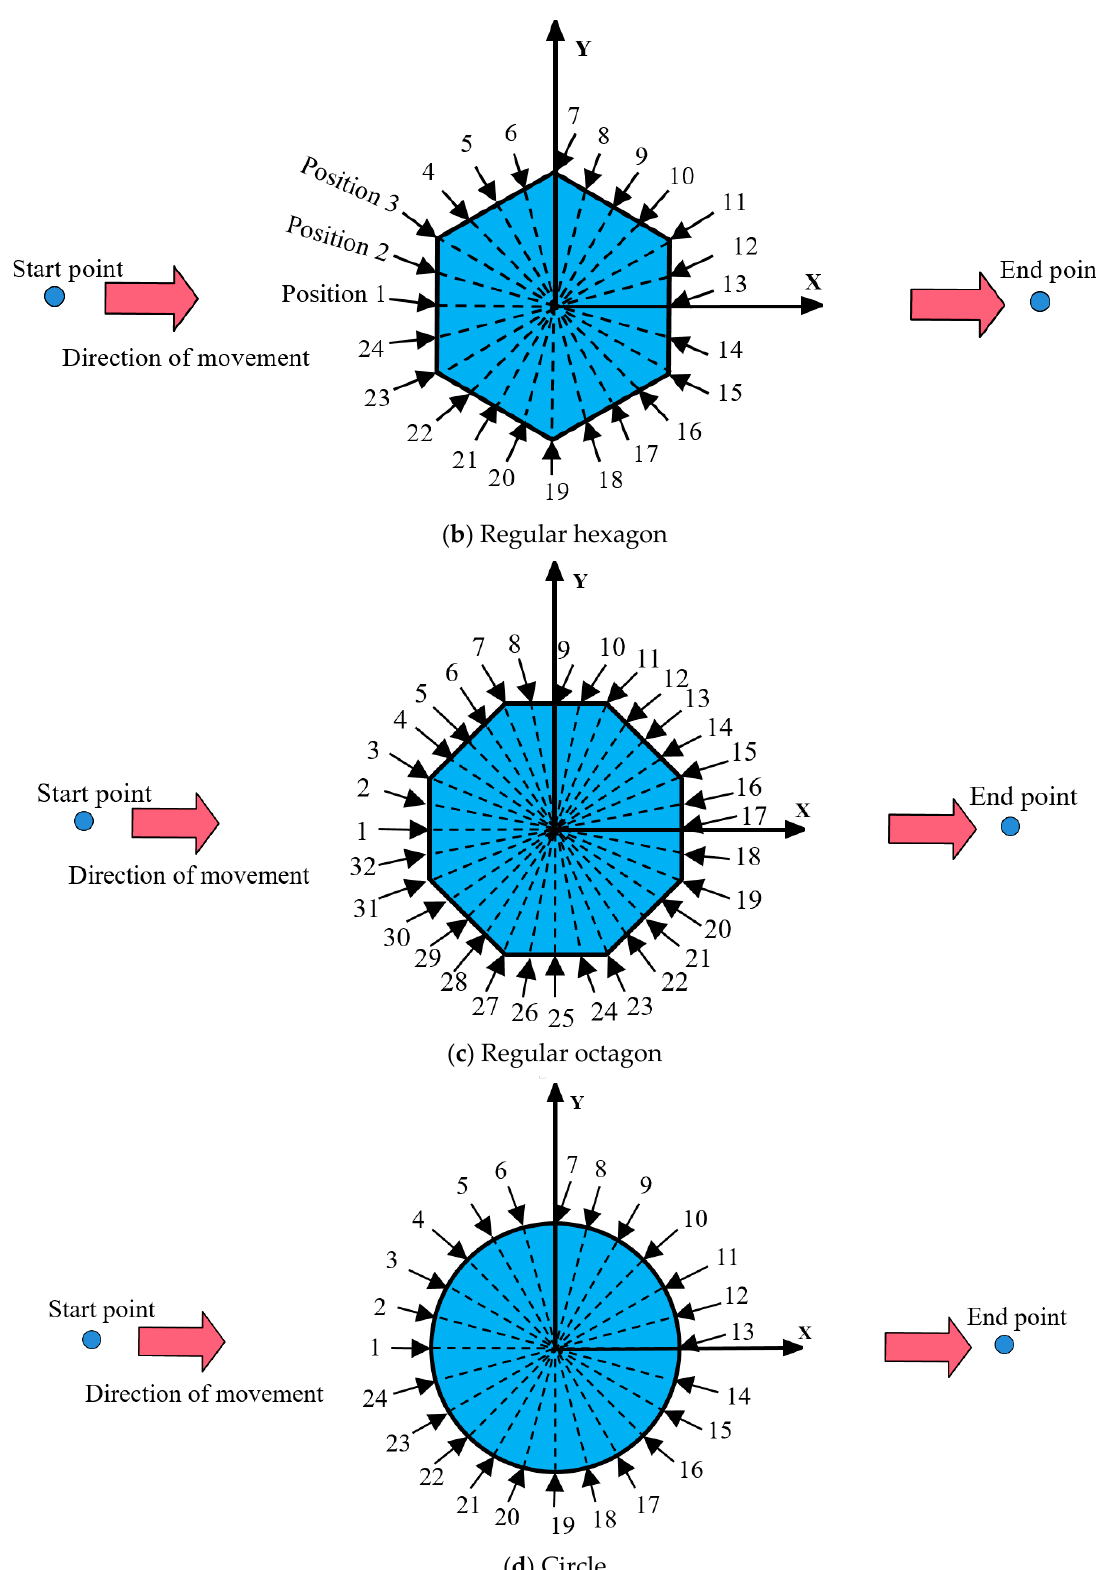
Figure 11. Schematic diagram of dividing the orientation of geometry with different shapes.